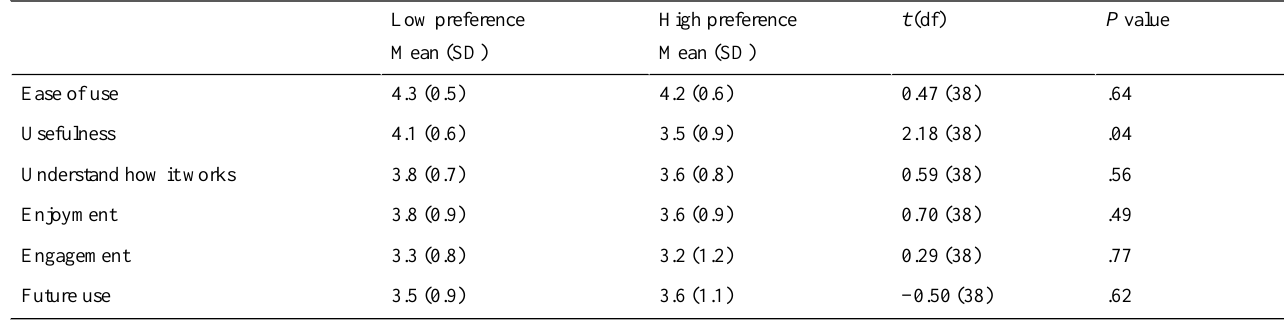
Table 8. User experience a